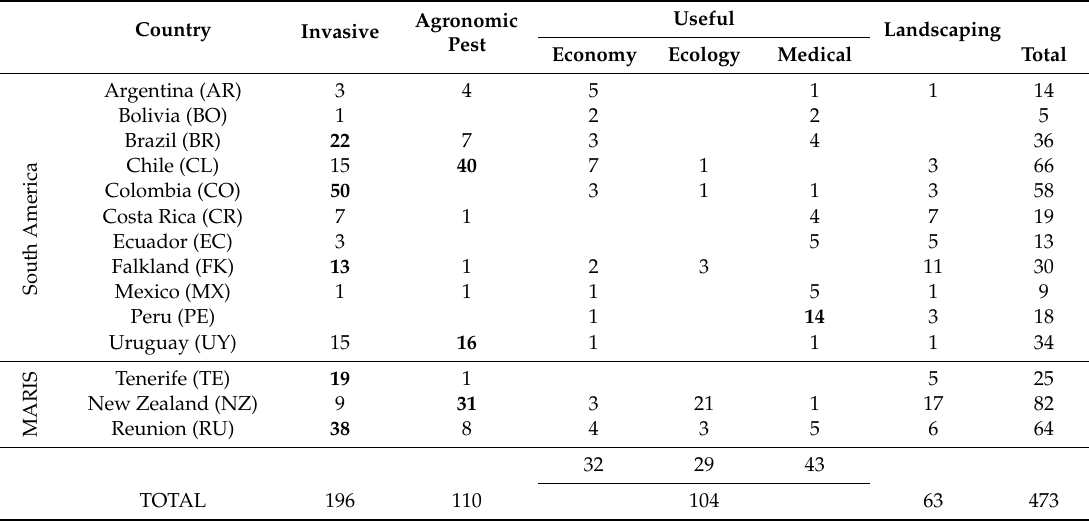
Table 2. The status of gorse identified in the di ff erent countries by web requests. In bold, the most frequent. Country Invasive Agronomic